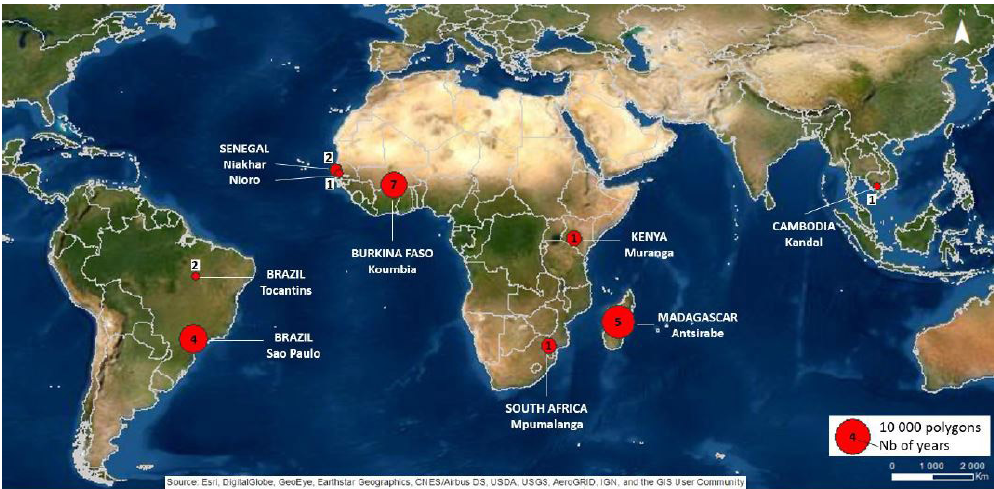
Figure 1. Location map of the study sites and the associated number of collection years and sampled plots (symbolized by the size of the red circles).